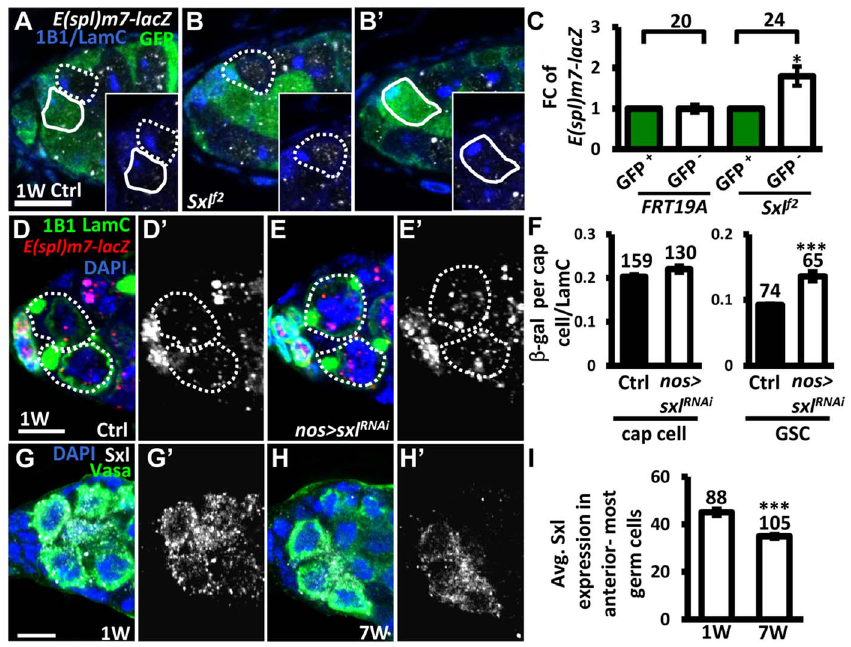
Fig. 6. Sxl negatively regulates Notch signaling in GSCs, and its expression is reduced in GSCs with age. (A and B) One-week (w)-old control (ctrl) (A) and sxl f2 mosaic germaria (B) with GFP (green, wild-type (wt) cells), ß-gal (gray, E(spl)m7-lacZ , a N reporter), 1B1 (blue, GSC fusomes), and LamC (blue, cap cell nuclear envelopes) labels. Wt GSCs are outlined by solid circles, and control or mutant GSCs (GFP-negative ( 2 )) are outlined by dashed lines. B and B 9 are images from the same germarium, but taken from different focal planes. (C) Average fold changes (FC) of E(spl)m7-lacZ expression in GFP 2 GSCs as compared to those of wt GSCs within the same niche at 1w after clone induction. The number of mosaic germaria analyzed is shown above each bracket. (D–E) One-w-old control (ctrl) (D) and nos-GAL4- driven sxl RNAi germaria (E) with E(spl)m7-LacZ (red, N reporter), 1B1 (green, fusomes), and LamC (green, cap cell nuclear envelopes) labels. GSCs are outlined by dashed lines. E(spl)m7-lacZ signals are shown in gray in D 9 and E 9 . (F) Ratio of average ß-gal signals in cap cells and GSCs to average LamC expression in cap cells (internal control) in 1-w-old ctrl and sxl - knock down germaria. (G and H) One-w (G) and 7-w-old germaria (H) with Sxl (gray), Vasa (green, germ cell), and DAPI (blue, DNA) labels. G 9 and H 9 show the Sxl channel only. (I) Avg. Sxl expression in anterior-most germ cells of 1 and 7-w-old germaria. The number of cells analyzed is shown above each bar in F and I. *, P , 0.05; **, P , 0.01. Error bar, mean 6 SEM. Scale bars, 5 m m. The genotype of the ctrl is hs-flpneoFRT19A/ubiGFPFRT19A; E(spl)m7-LacZ/ + in A and C, and nos-gal4-vp16E(spl)m7-LacZ/ + in D and